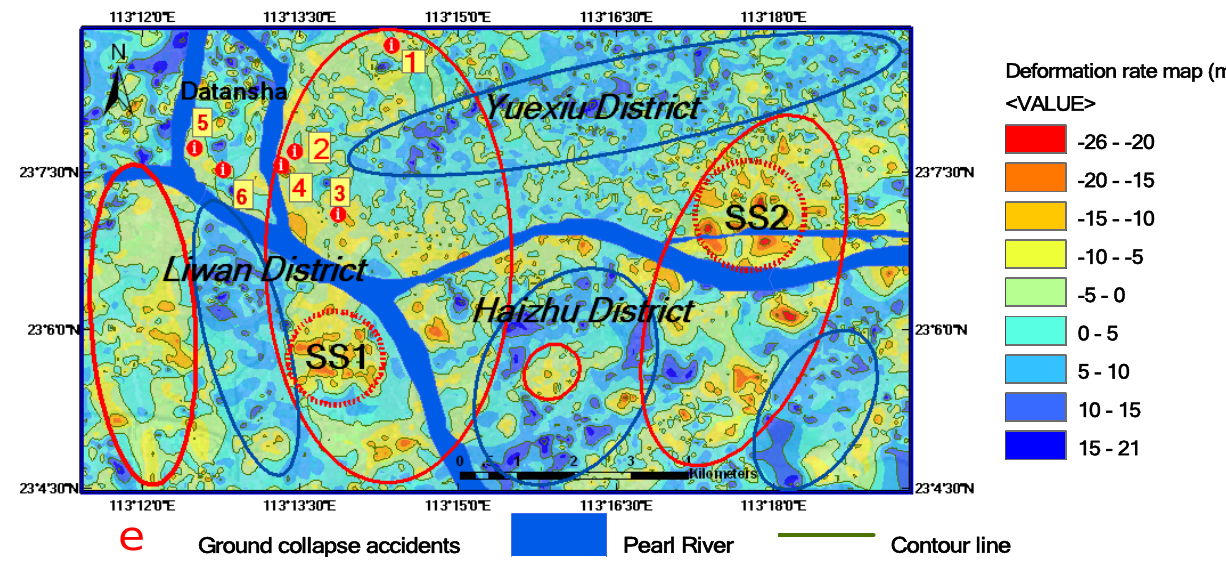
Figure 5. A contour map of ground deformation in Guangzhou